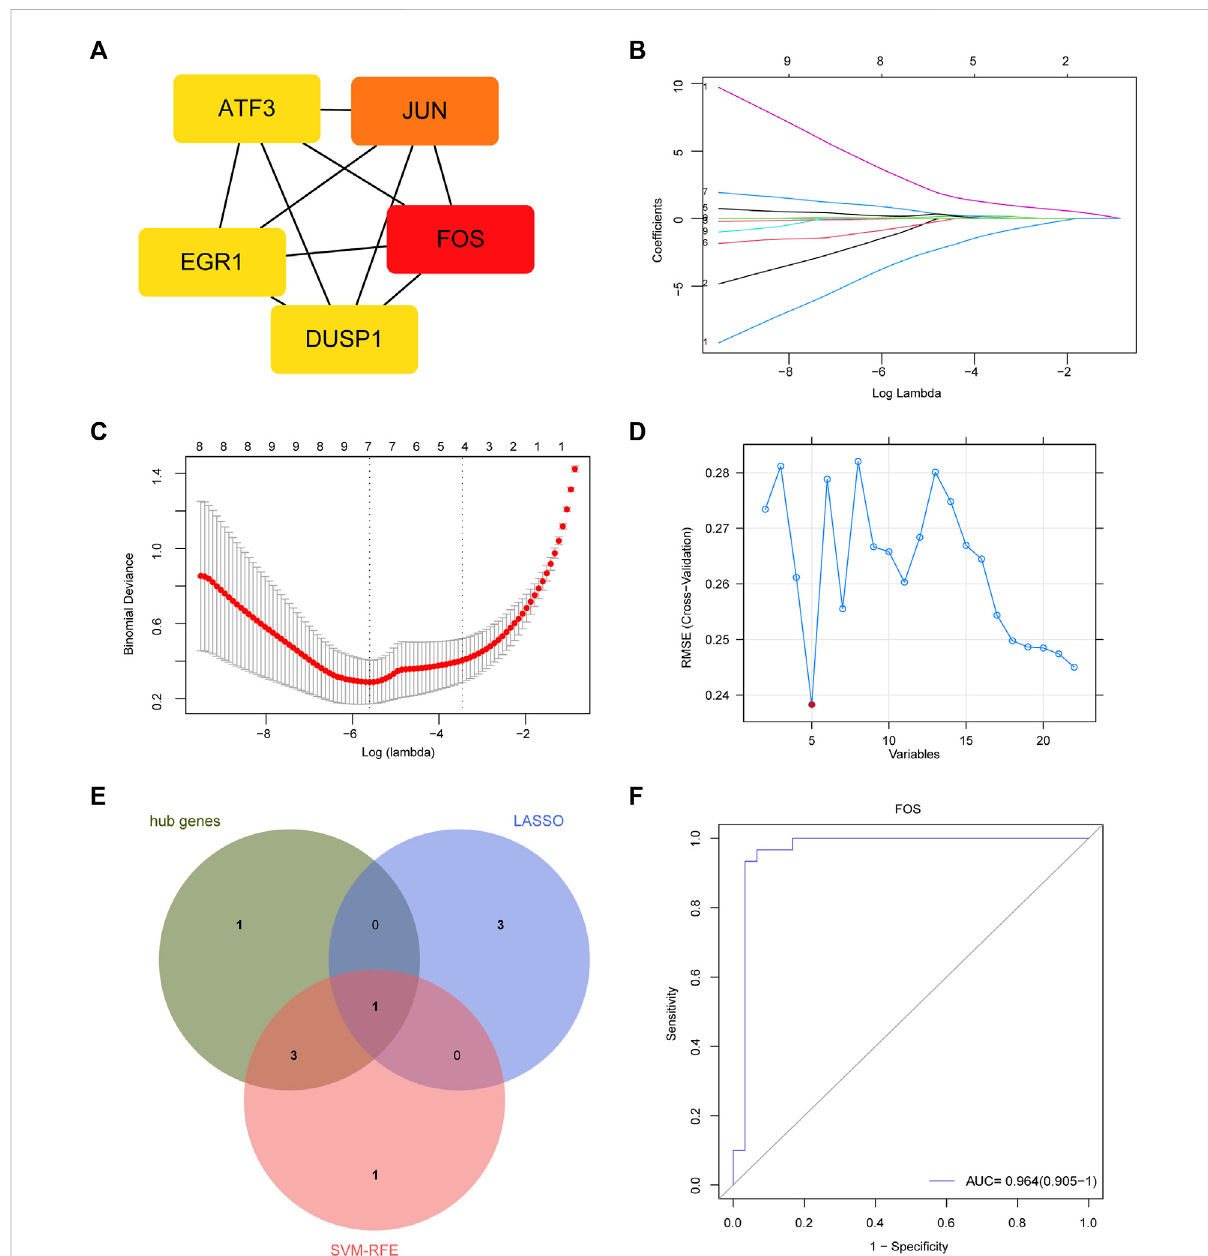
Feature gene and its diagnostic value. (A) Protein-protein interaction (PPI) network and hub genes: FOS, JUN, ATF3, DUSP1, EGR1 . (B) LASSO coef fi cient pro fi les. (C) Identi fi cation of the optimal penalization coef fi cient (lambda) in the Lasso regression and the minimum absolute contraction criterion. (D) A plot of feature genes selected by SVM-RFE machine learning. The red dot represents the best fi ve variables. (E) Venn plot demonstrates FOS wasanimportantmarkercombinedbyLASSO,SVM-RFEandhubgenes. (F) Thediagnosticperformanceof FOS accordingto its expression. AUC, area under the ROC